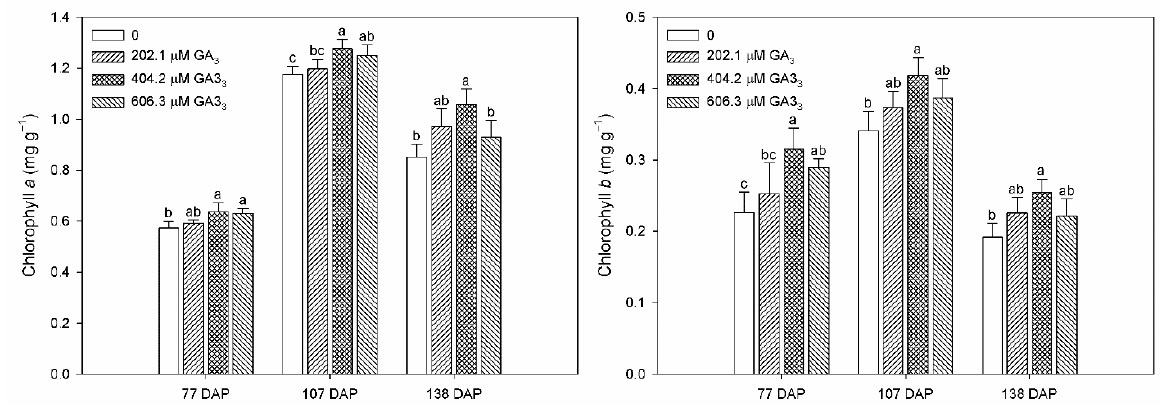
Figure 2. The effects of GA 3 level on the chlorophyll a and b of sesbania pea at three growing dates grown in saline soils. Within each group, the data marked with different letters are statistically different at the 0.05 probability